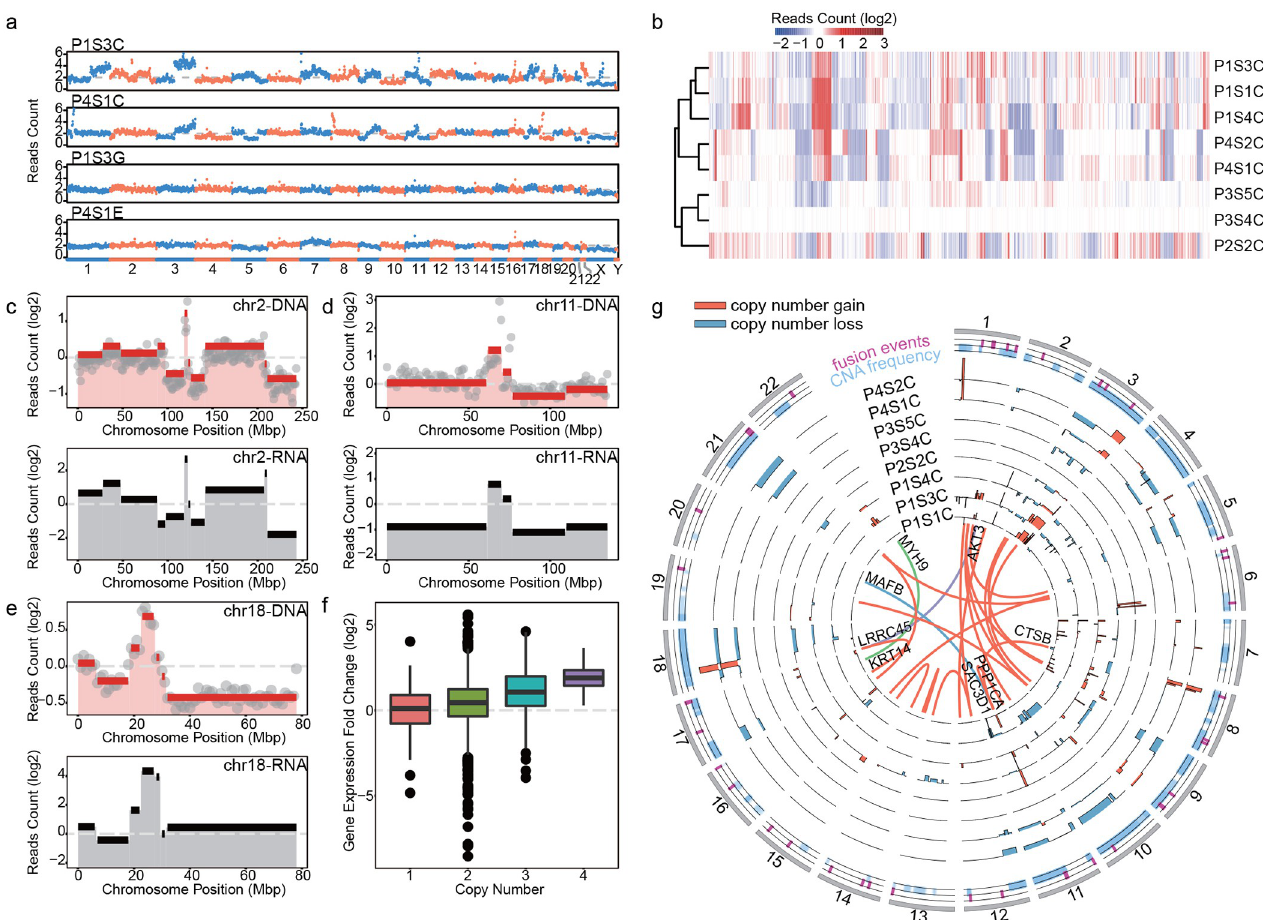
Fig 4. Genomic and transcriptomic analysis of laser dissected tissue samples. (a) Raw reads count across the whole genome of 2 paired cancer-normal tissues dissected from the same slice. Chromosome numbers were labeled at the bottom. (b) Unsupervised clustering of normalized reads counts of all the dissected cancer samples. (c, d) Top panels demonstrated the normalized read count (gray dots) and copy numbers (red lines) identified by CBS algorithm in chromosome 2 and 11 of sample P1S3C and P1S1C, respectively. Mean expression levels within the same segment were shown in black lines in the bottom panel. (e) Averaged read counts of all the cancer samples (top) and their corresponding gene expression values (bottom) of chromosome 18. Genome and transcriptome variations of other chromosomes and samples were shown in S16, S18, and S19 Figs. (f) Averaged gene expression fold changes were computed per 1 M bin across the whole genome and plotted against copy numbers. (g) The distribution of CNA and fusion genes across the genome of all the cancer samples. Orange and blue bars indicated the copy number gains and loss, respectively. Orange lines in the inner circle indicated fusion genes with at least 10 span pair reads, and the green and purple lines represented oncogenes involved gene fusions. The position of fusion events (magenta) and CNAs (light blue) of all the cancer samples were shown in the 2 outmost circles. Source data for panel b–g in S2 Data Sheet 2.5–2.20. CNA, copy number alteration.